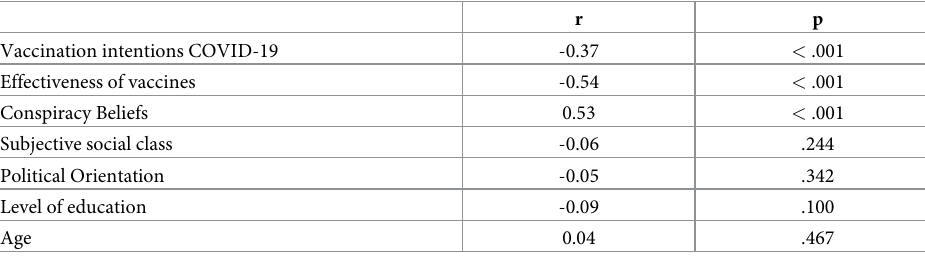
Table 6. Correlations between the different variables presented in Study